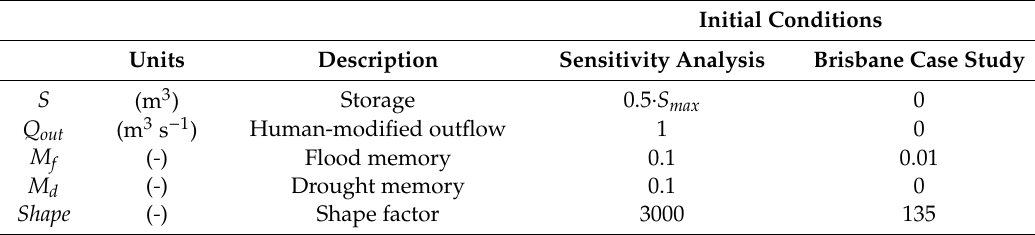
Table 1. Time-varying variables of the reservoir management module and initial conditions used in the sensitivity analysis and the Brisbane case